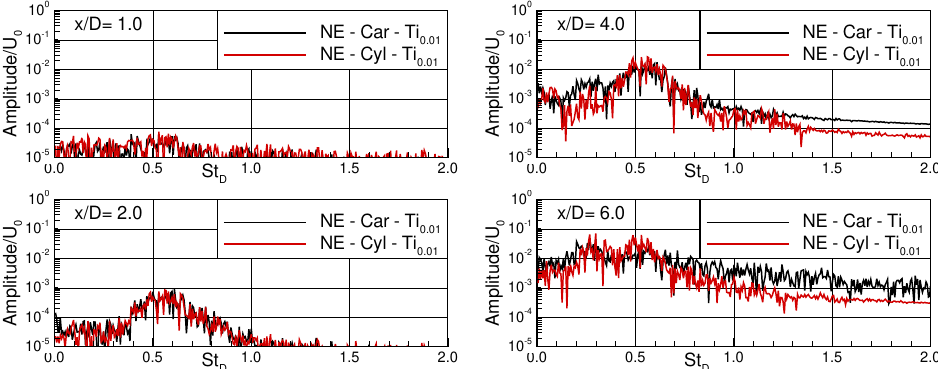
Figure 4. Evolution of the spectra of the axial velocity fluctuations registered at the jet axis. The results obtained for NE − Car − Ti 0.01 and NE − Cyl − Ti 0.01